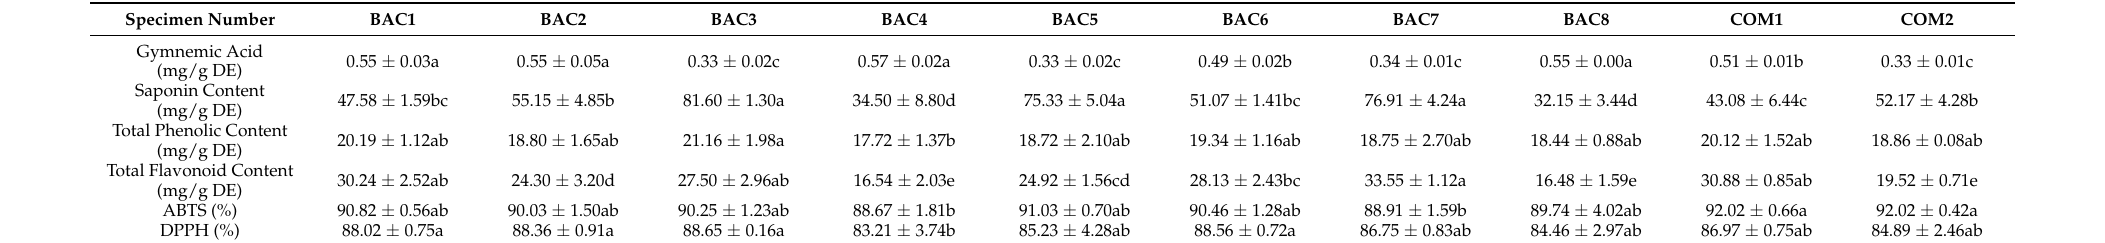
Table 4. Phytochemicals and antioxidant activities of Gymnema inodorum